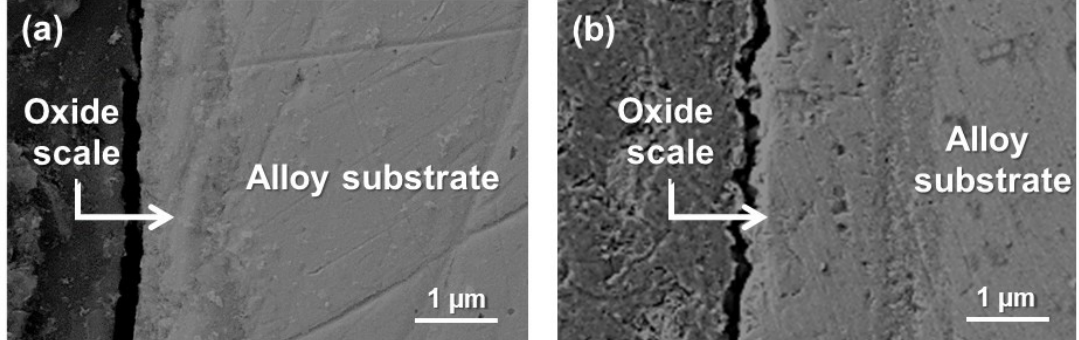
Figure 6. Cross-sectional SEM images of DS2507 exposed to molten salts for: ( a ) 300 h, and ( b ) 1600 h.